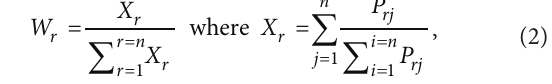
Table 1. Saaty’s pair-wise comparison